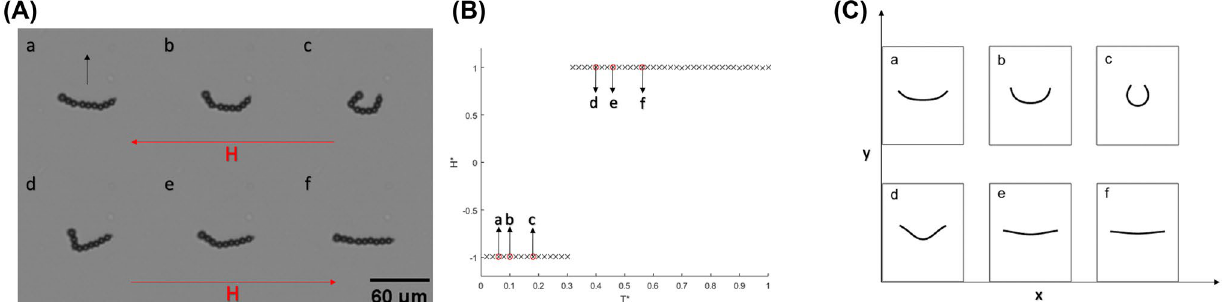
Figure 1. ( A ) An example of filament ‘U’ deformations under a 30 % duty cycle pulse wave profile magnetic field, at different location within one period for filament with length L = 60 µ m, field frequency f = 2 Hz and field strength H = 5.2 Oe. The arrow in ‘a’ shows the swimming direction. ( B ) Magnetic field measurements vs time over one period where H ∗ = H / H max and T ∗ = t / T . The red circles show the readings that correspond to images (a–f) in both ( A ) and ( C ). ( C ) Filament shapes obtained by numerical simulations which are scaled with experiments shown in ( A ), Cm = 51 and T /τ = 0.0092